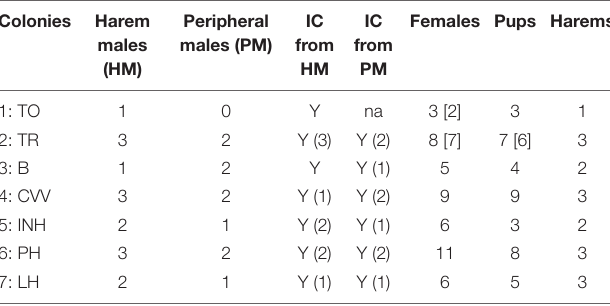
Representation of the IC production and the social group composition of each monitored colony. Numbers in parentheses depict how many males of the respective colony residents were observed to produce ICs (column 4 and 5). Numbers in square parentheses depict changes in colony social group composition during the field seasons as females (and their respective pups) sometimes disappeared. Colonies 1–4 belong to the Costa Rican population, colonies 5–7 belong to the Panamanian